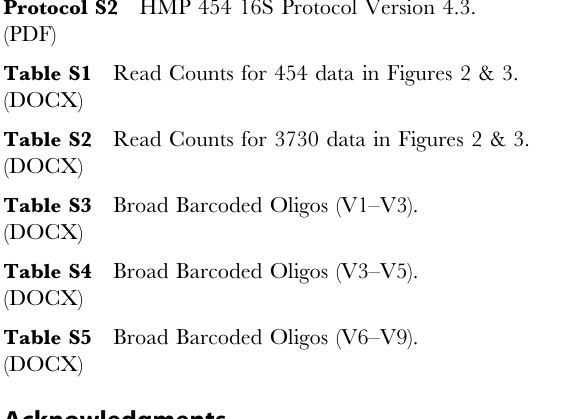
quality filtering and chimera checking, as evaluated by rarefaction analysis. The number of observed OTUs in the MC is shown as the function of the number of 3730 (A) and 454 (B) sequences, before filtering (black), after quality filtering (green, 454 only), and after combined quality and chimera filtering (red). Rarefaction curves were generated using mothur, with an OTU defined at 97% similarity. (A) For 3730, separate lines show the rarefaction curves for the three different sequencing approaches. (B) For 454, rarefaction curves for the three 16S windows spanning the variable regions V1–V3, V3–V5, and V6–V9 are shown separately, and analysis was performed on a random 10,000- sequence subset from each